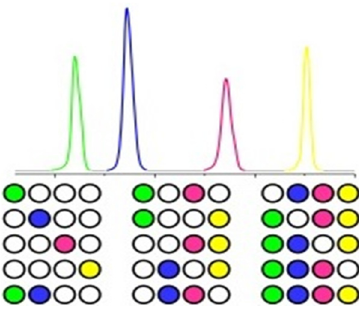
Figure 1. In product barcodes based on phase change nanomaterials for agrochemical